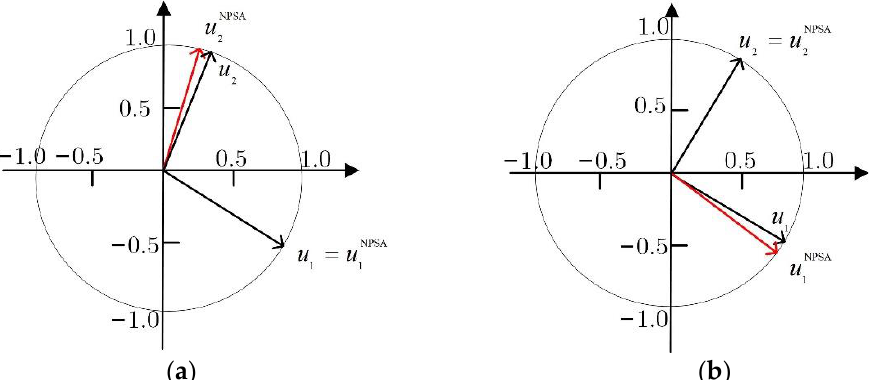
Figure 3. The distribution of two true eigenvectors, and those obtained by NPSA in a unit circle. ( a ) The first result was obtained with NPSA; ( b ) the second result was obtained by NPSA.